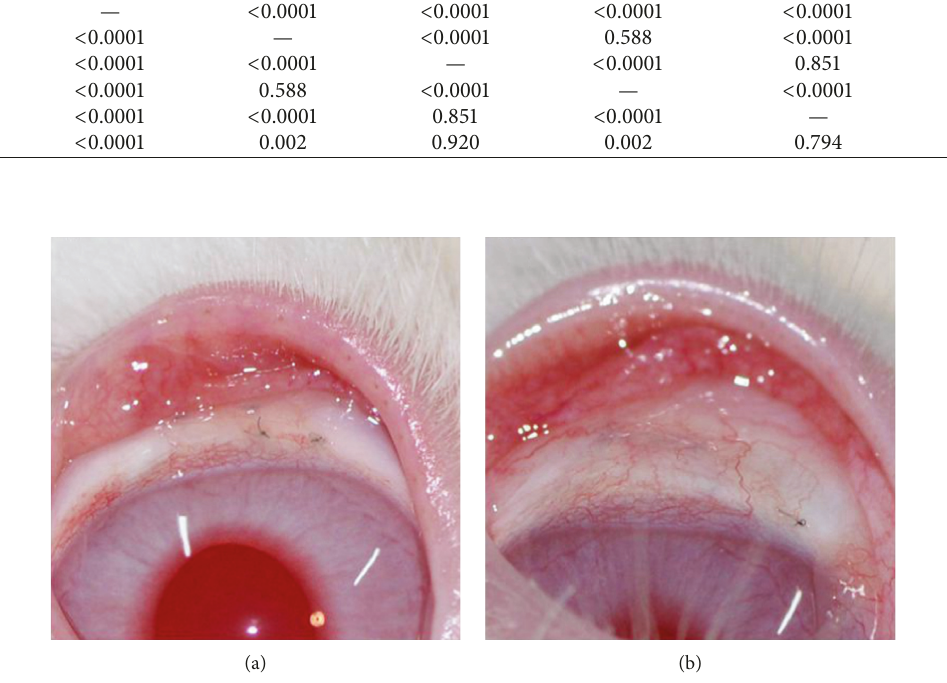
Figure 5: Kaplan–Meier analysis of the survival time of filtering blebs in each Table 2: Kaplan–Meier analysis and Mantel–Cox log-rank test of the survival time of filtering blebs in each group. Group